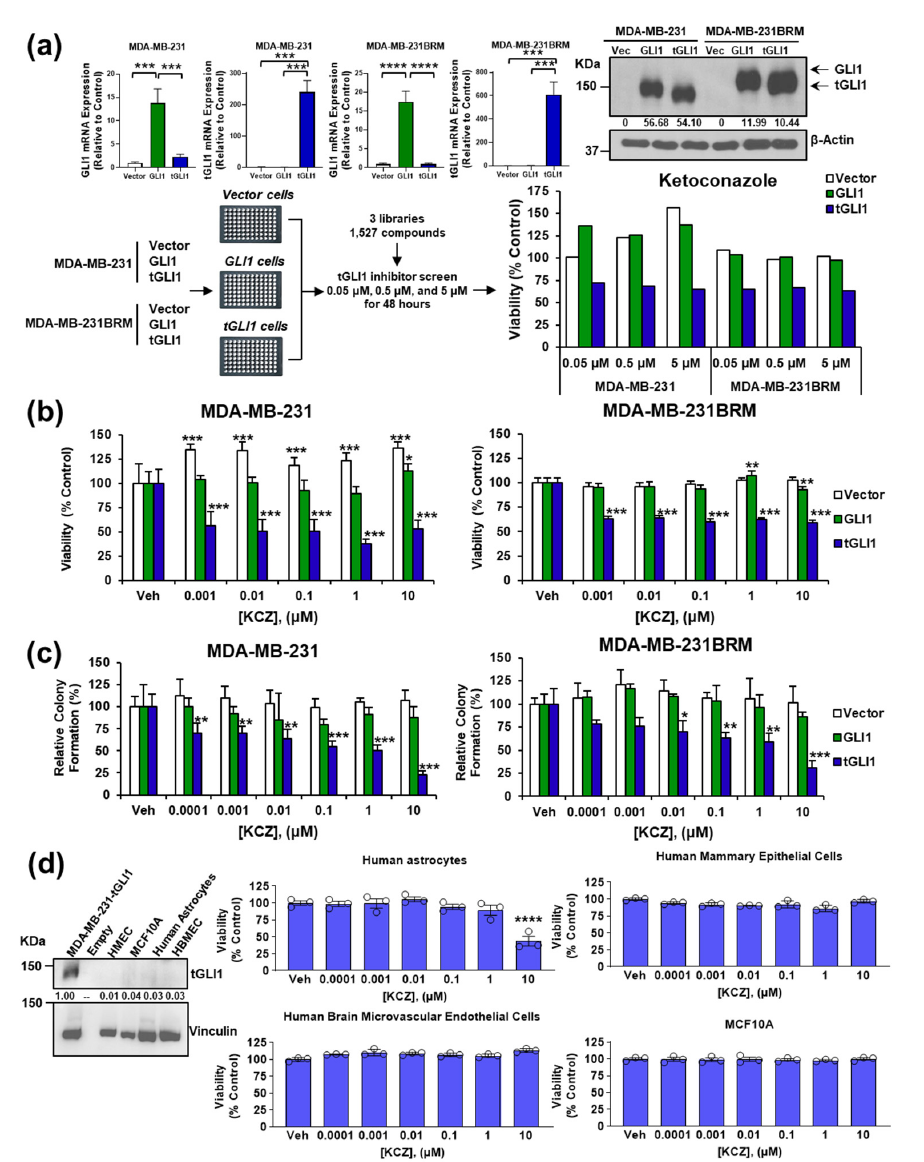
Figure 1. KCZ selectively inhibits breast cancer cells expressing tGLI1 with increased potency against the CSC population. ( a ) Confirmation of MDA-MB-231 and MDA-MB-231BRM cell lines stably expressing control vector, GLI1-, or tGLI1-expression vectors using RT-qPCR and a Western blot analysis. Schematic summarizing the first phase of the tGLI1 inhibitor screen that flagged KCZ as a potential tGLI1 inhibitor. MDA-MB-231 and MDA-MB-231BRM cell lines stably expressing the control vector, GLI1-, or tGLI1 expression vectors were seeded in 96-well plates and treated with the test compound. ( b ) KCZ’s effects were confirmed by a dose-escalating screen to confirm tGLI1 selectivity. Asterisks denote results of intra cell line post hoc Dunnett’s multiple comparison test against vehicle treatment. ( c ) Colony formation assay in which MDA-MB-231 and MDA-MB-231BRM cells stably expressing either an empty vector, GLI1, or tGLI1 were seeded at a low density (250 cells/well) and treated for 10 days. Asterisks denote results of post hoc Dunnett’s multiple comparison test against vehicle treatment. ( d ) The tGLI1 protein expression in normal brain and breast microenvironmental cells using a Western blot analysis. The positive control is represented by the breast cancer cell line MDA-MB-231 stably overexpressing tGLI1. Ketoconazole activity against normal brain and breast microenvironmental cells. Note: *, p < 0.05; **, p < 0.01; ***, p < 0.001; ****, p < 0.0001; two-way ( b , c ) or one-way ( d ) ANOVA with post hoc Bonferroni’s or Dunnett’s multiple comparison test, respectively. The uncropped blots are shown in page 1 of supplementary materials File